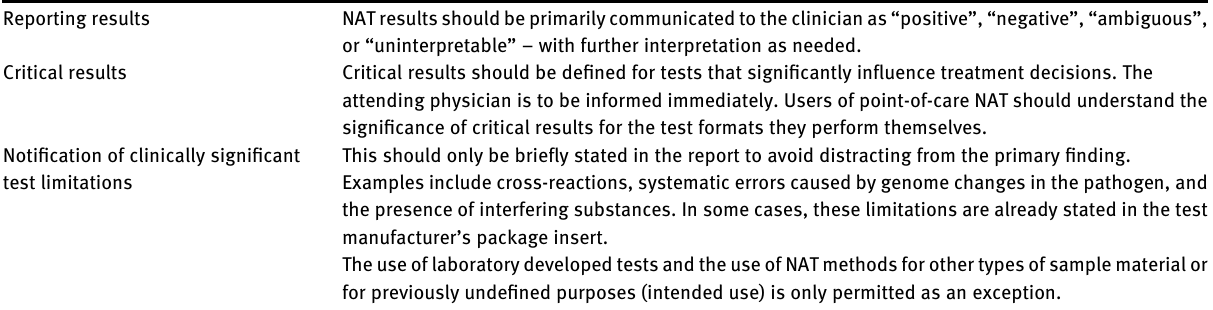
Table  : Issuance and interpretation of results as per the Clinical & Laboratory Standards Institute (CLSI) document [  ]. Reporting results